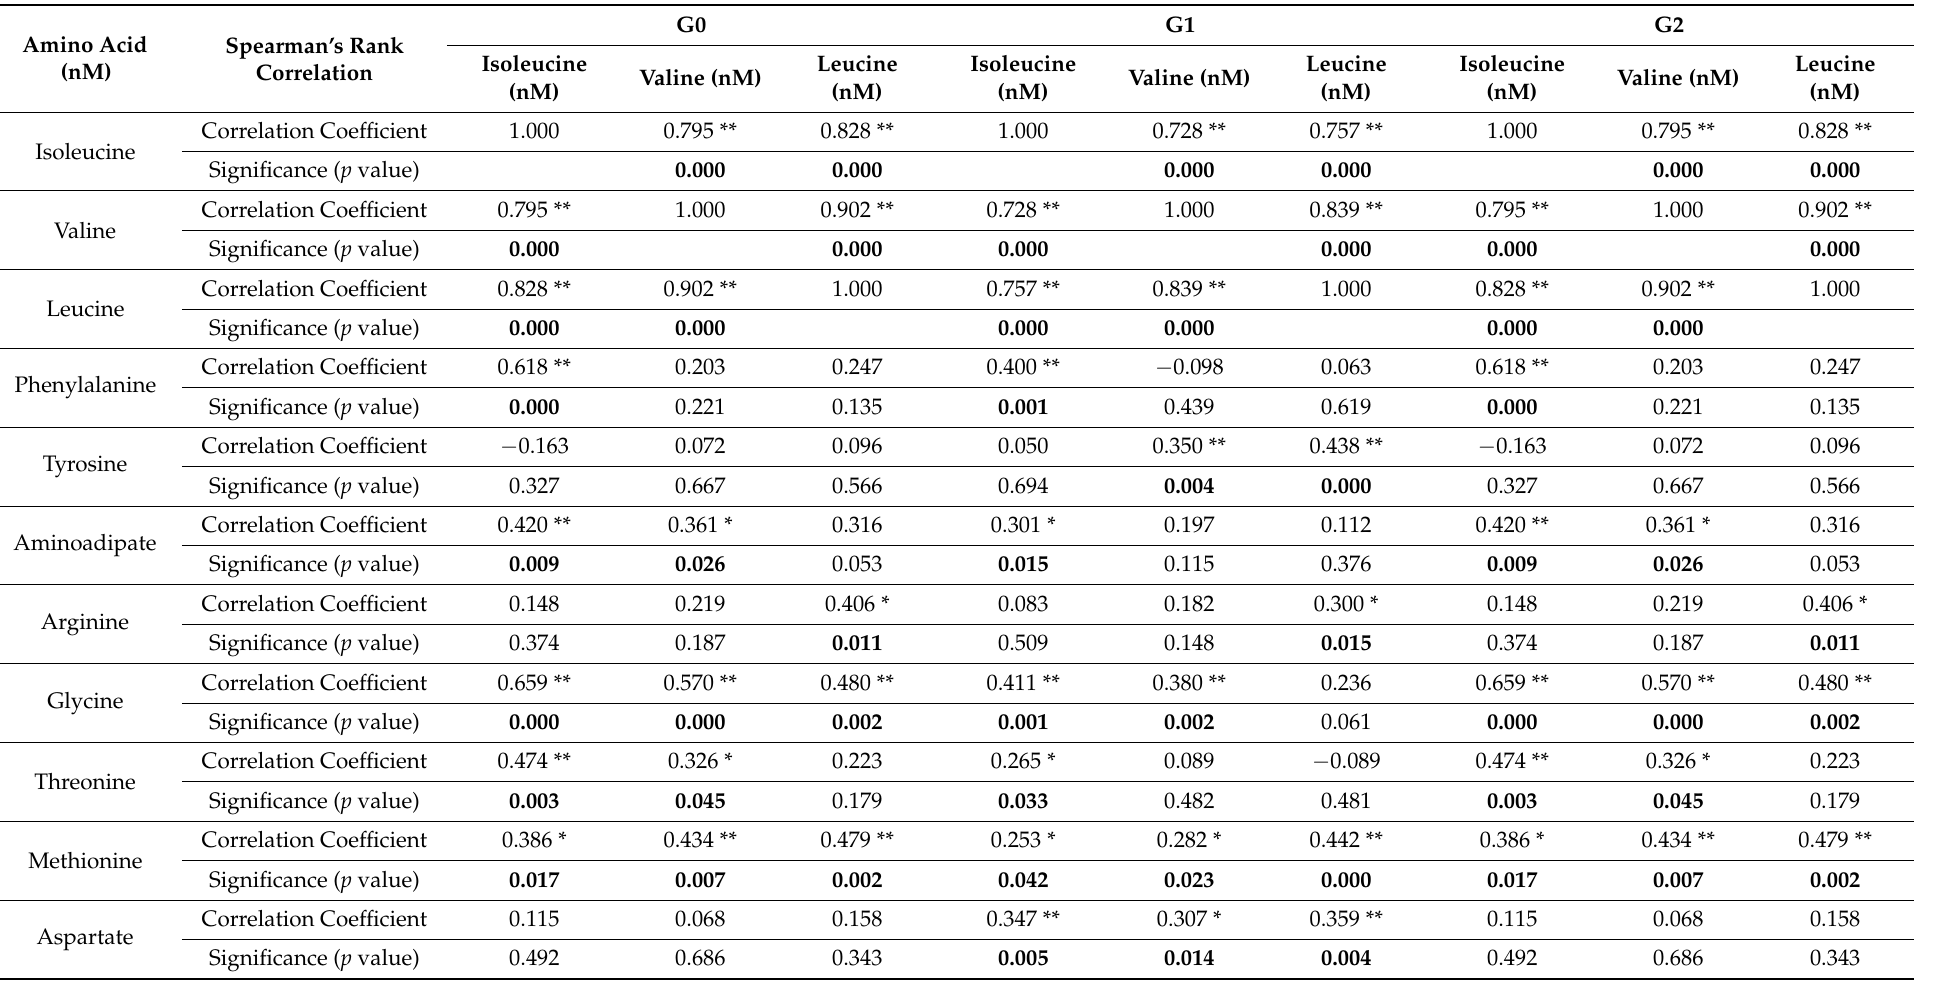
Table 2. Correlation coefficient (r) and significance ( p ) using the spearman’s rank correlation test for healthy controls (G0), single-treated (G1) and multi-treated (G2) type 2 diabetes mellitus groups for the Branched chain amino acids (BCAA). * Correlation is significant at the 0.05 level (2-tailed); ** Correlation is significant at the 0.01 level